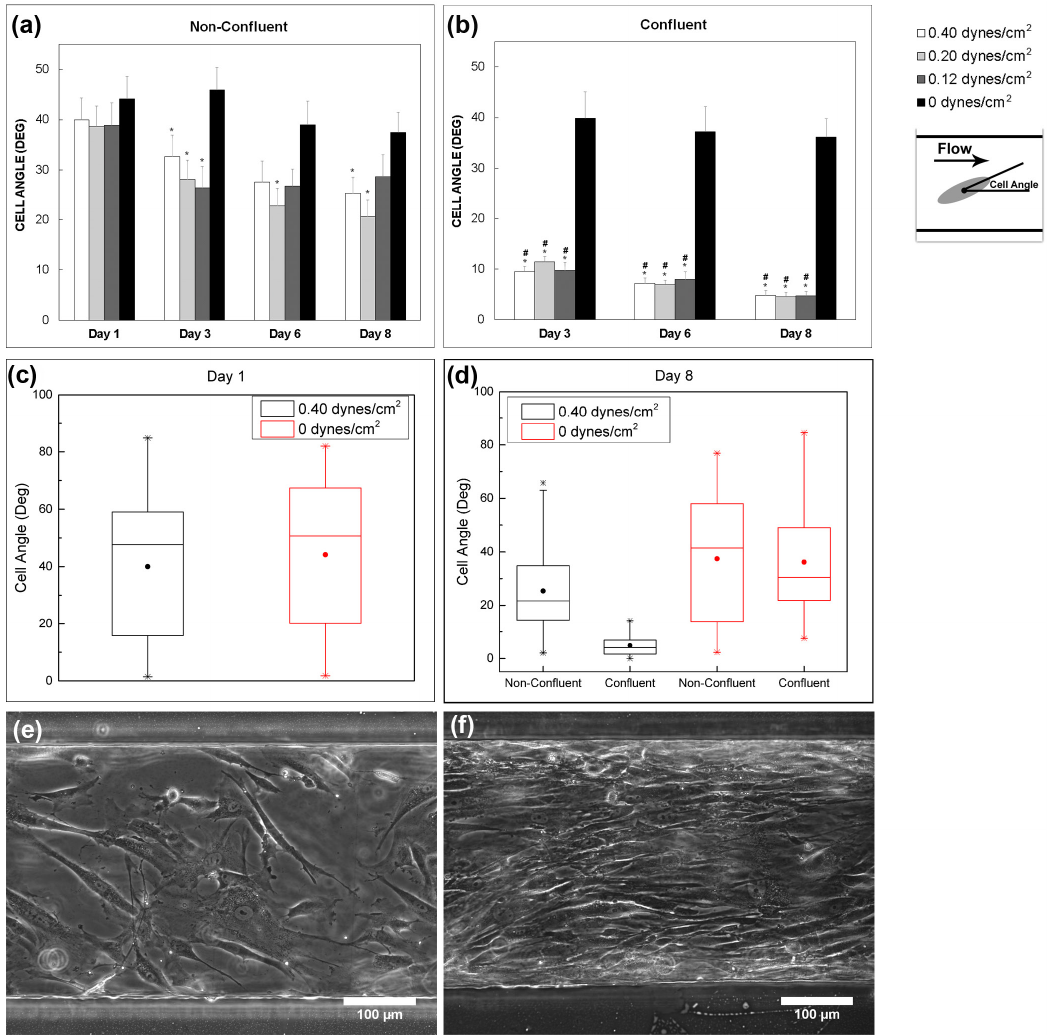
Figure 4 . Effect of shear stress on MSC alignment (average cell angle). Average cell angle was plotted at different time points and shear stress values for ( a ) non-confluent regions and ( b ) confluent regions. Day 1 angle measurements were taken after MSC attachment and just prior to flow. * indicates a statistical difference between the flow based conditions and the static control. # indicates a statistical difference between the confluent and non-confluent angle measurements for a given shear stress condition and time point ( p < 0.001). MSCs were seeded at a non-confluent state, so no confluent regions were present on day 1. Cell angles for the 0.40 and 0 dynes/cm 2 conditions were also plotted as box plots for ( c ) day 1 and ( d ) day 8. The lower and upper boundaries of the box represent the first and third quartiles respectively, while the line within the box represents the median of the data. The whiskers represent the minimum and maximum data points not including outliers. The solid circle indicates the mean value and * indicates the minimum and maximum data points including outliers. ( e ) Representative non-confluent region of the 0.40 dynes/cm 2 device on day 3. ( f ) Representative confluent region of the 0.40 dyes/cm 2 device on day 3. N = 30 cells were measured per shear stress for each time point and cell density. The static controls (0 dynes/cm 2 ) were cultured on polystyrene cell culture treated petri dishes. Error bars represent